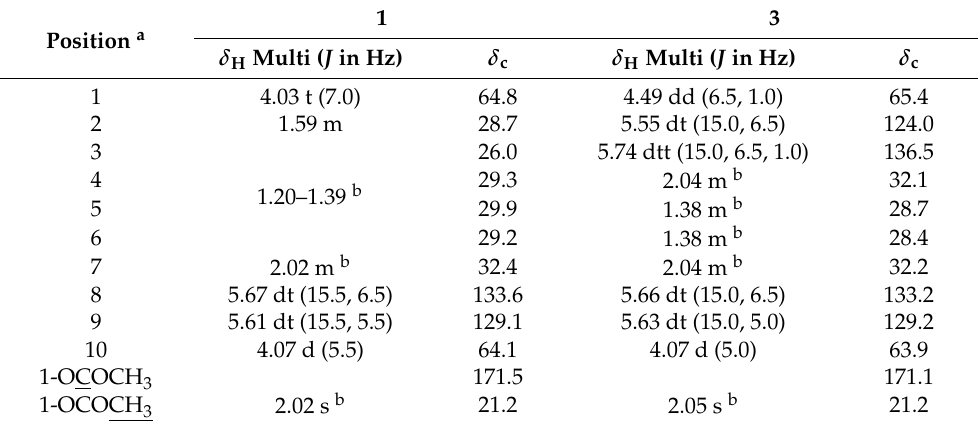
Figure 2. Selected correlations observed in the COSY ( ▬ ) and HMBC ( → ) NMR spectra of com- pound 1.